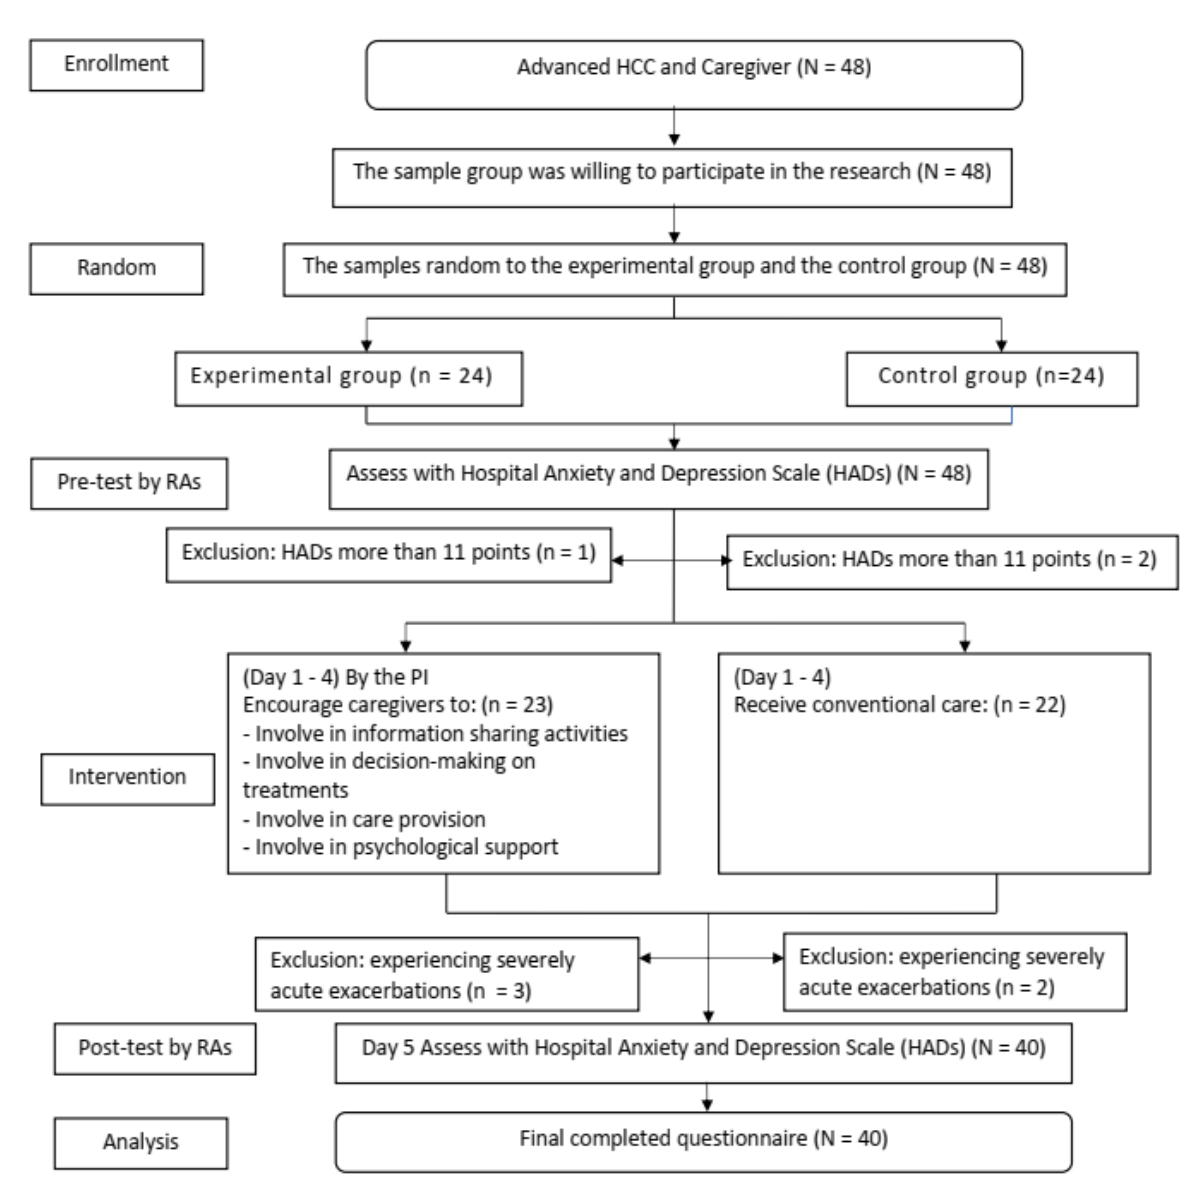
Figure 1. Flow diagram of the participants in the study.